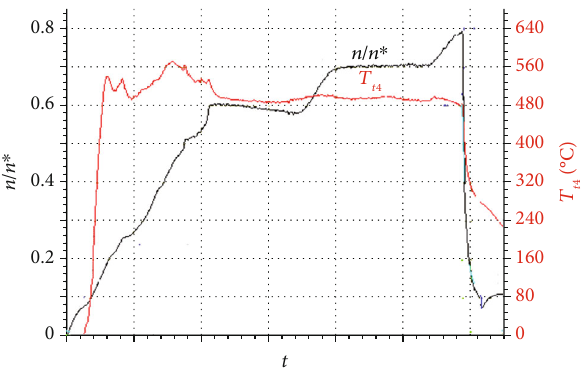
Figure 4: Experimental results of engine test with the original combustor.